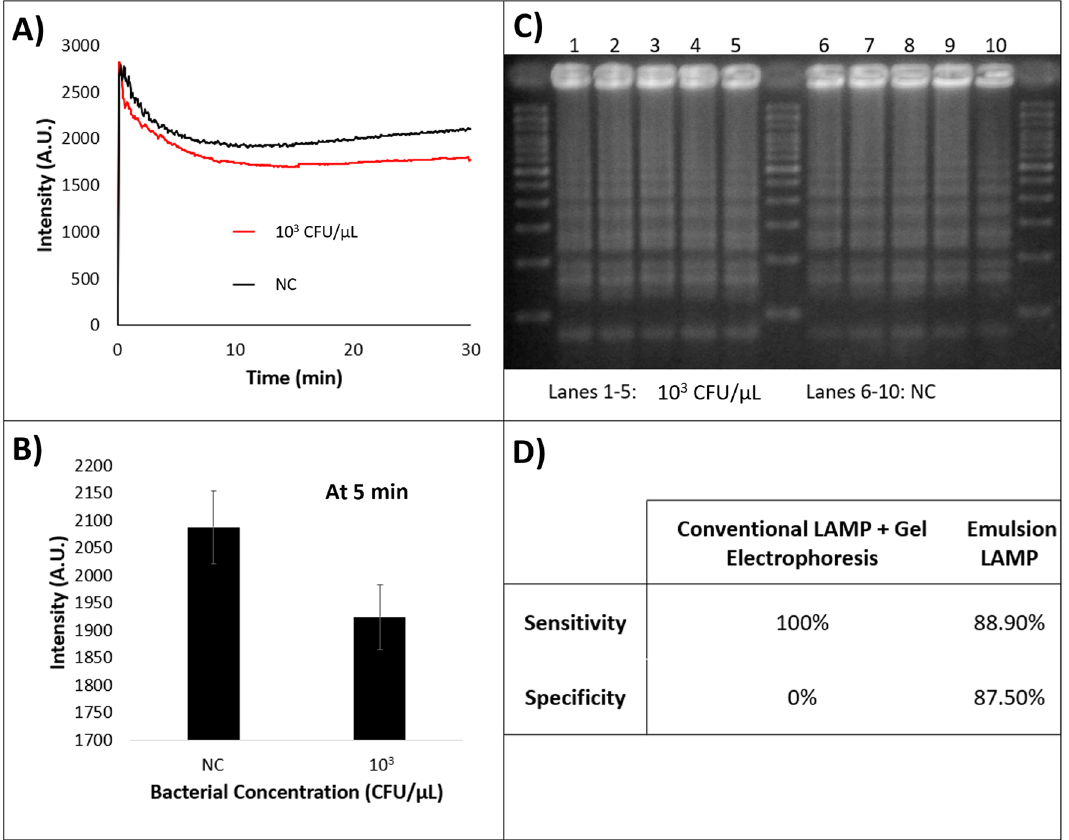
Figure 6. Sensitivity and specificity in comparison to conventional LAMP. ( A ) Average 30° light scatter intensity profiles for 10 3 CFU/μL and NC (negative control) samples. ( B ) Comparison of light scatter intensity values at 5 min between initial target bacterial concentrations. ( C ) Gel image showing amplification of both positive (left lanes) and NC (right lanes) samples after conventional amplification for 30 min. ( D ) Table detailing sensitivity and specificity of both conventional amplifications combined with gel electrophoresis and emulsion LAMP.